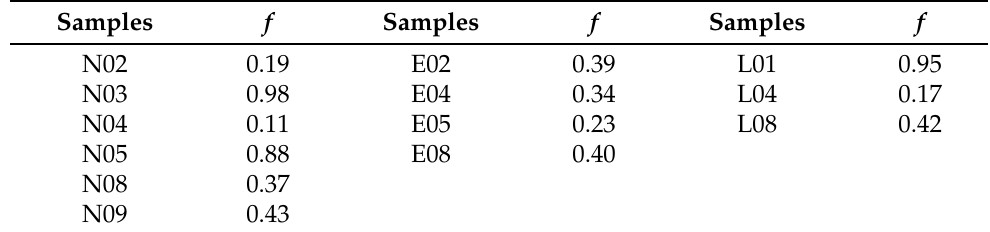
Table 3. Estimation of the constrictivity f from electrical tortuosity τ e and hydraulic tortuosity τ h . Samples